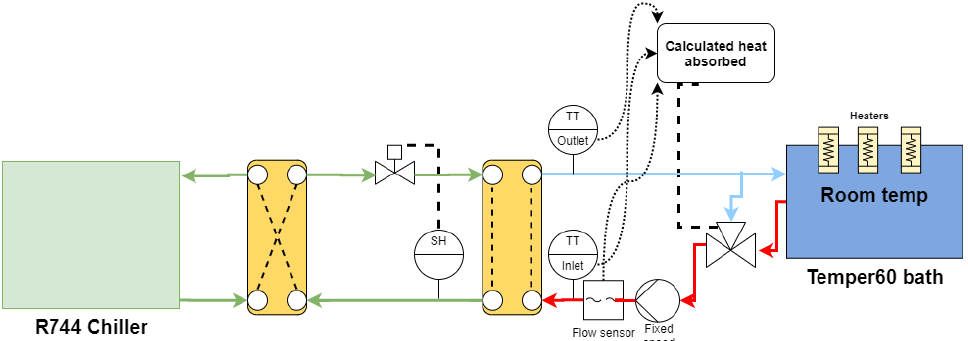
Figure 9. Dummy load simplified P&ID.